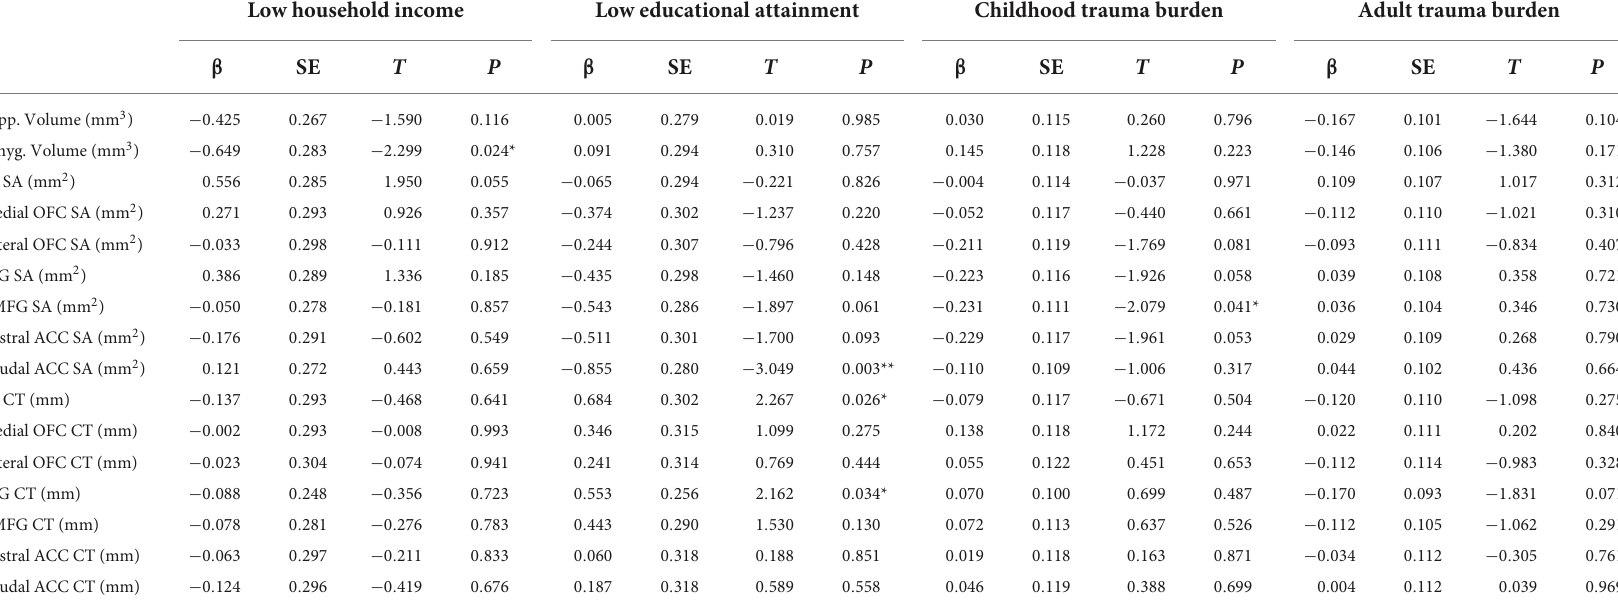
TABLE 2 Adverse social exposures (ASEs) predict average fronto-limbic brain